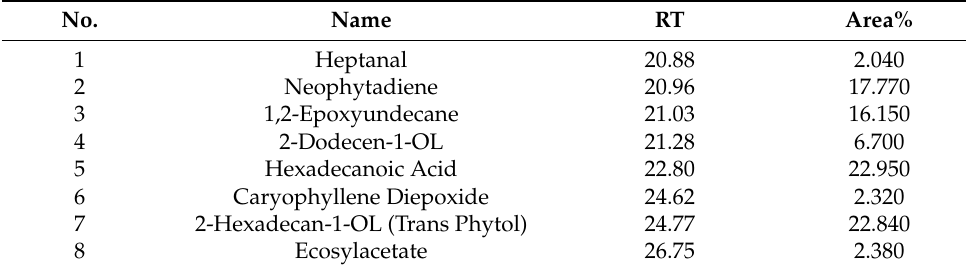
Figure 1. GC-MS chromatogram of B. lacera leaf extract. Figure 1. GC ‐ MS chromatogram of B. lacera leaf extract. Table 1. Major components of B. lacera leaf extract. Table 1. Major components of B. lacera leaf